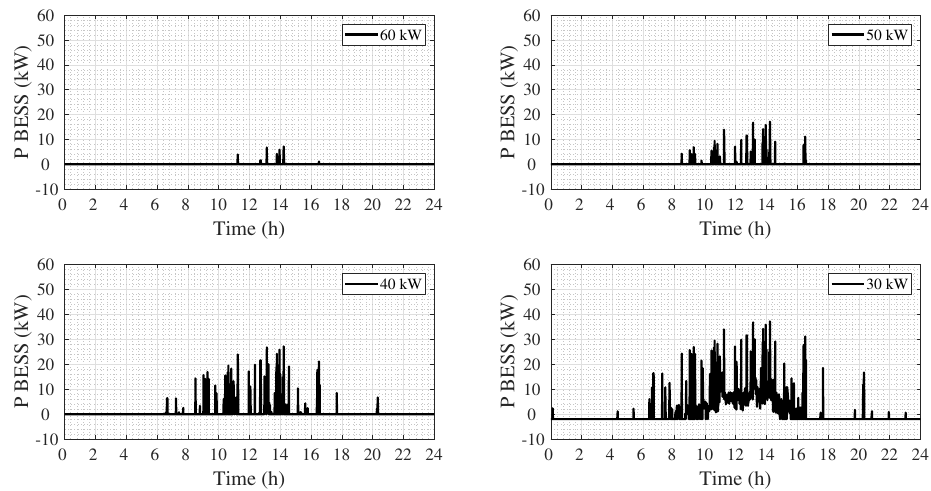
Figure 9. BESS power profile in summer for different values of P LIM .